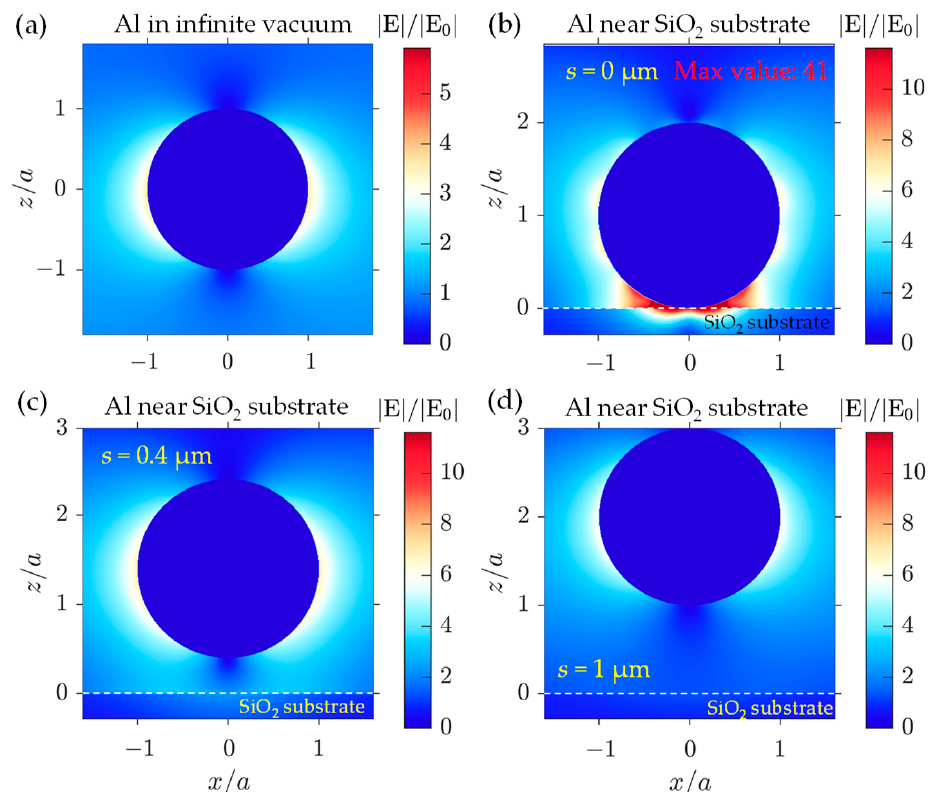
Figure 9. Normalized electric fi elds |E|/|E 0 | in xz -plane of an Al particle with a = 1 µm, where |E 0 | is the amplitude of the incident electric fi eld. The incident wavelength is selected at λ = 9 µm. ( a ) The electric fi elds of the Al sphere in the free space. ( b – d ) The electric fi elds of the Al sphere above SiO 2 substrate with the varied distances of ( b ) s = 0 µm, ( c ) s = 0.4 µm, and ( d ) s = 1 µm. It should be mentioned that the maximum number of normalized electric fi elds in ( b ) is 41.